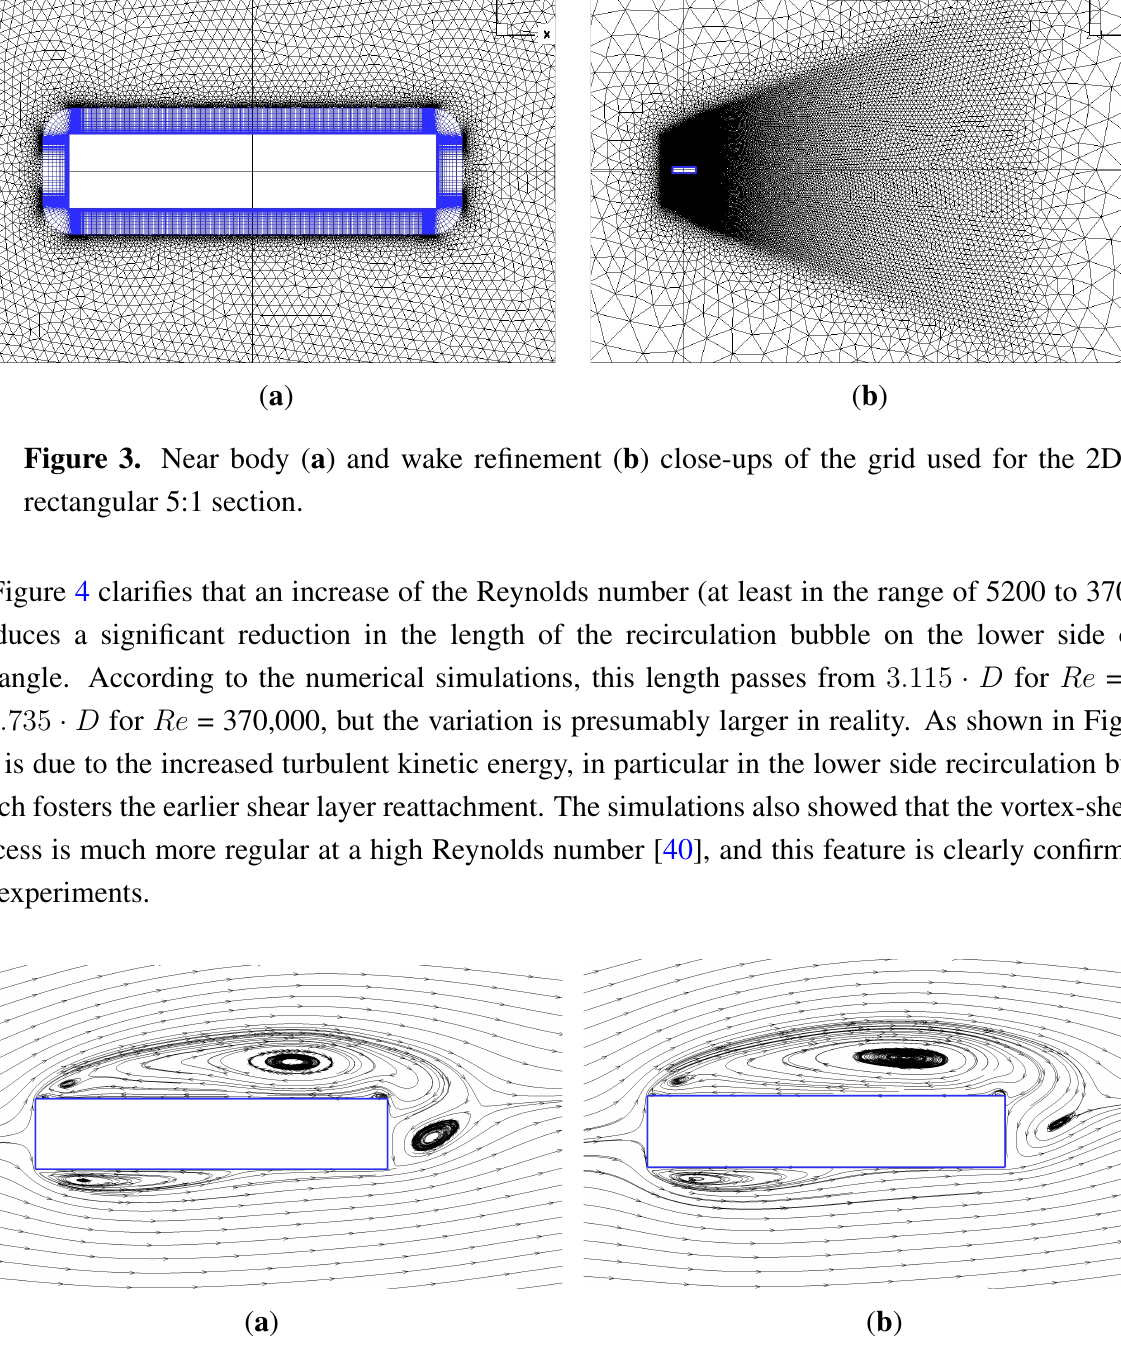
Figure 4. Streamlines of the time-averaged flow field calculated for the rectangular 5:1 cylinder with α = +4 ◦ at Reynolds numbers of 5200 ( a ) and 370,000 ( b